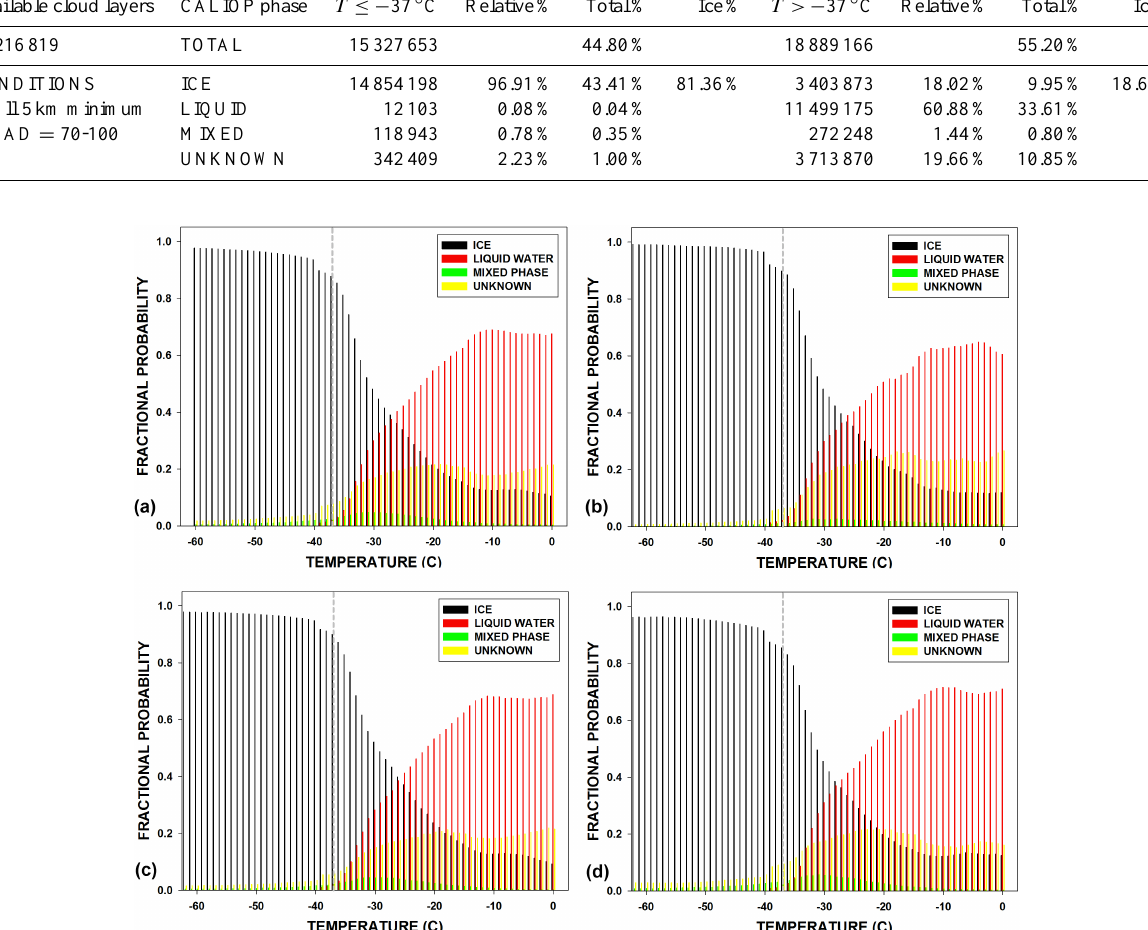
Figure 1. Fractional probabilities at 1 ◦ C intervals between − 60 and 0 ◦ C for each of the four cloud phase types (see text) identified from the 2012 CALIOP V3.02 L2_CPro-5km, including ice (black), liquid water (red), mixed-phase (green) and unknown (yellow), for (a) the global scale, (b) the tropics ( θ ≤ | 30 ◦ | ), (c) midlatitudes ( | 30 ◦ | < θ ≤ | 60 ◦ | ) and (d) polar regions ( θ > | 60 ◦ | ). Superimposed on these data is the − 37 ◦ C